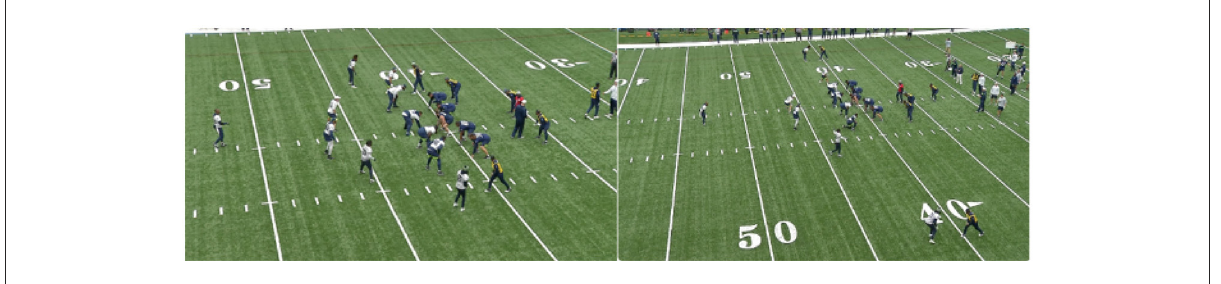
FIGURE1 Sample frames from practice videos. The frames are sampled a couple of seconds apart with different camera zoom levels offering varying visibility of the jersey